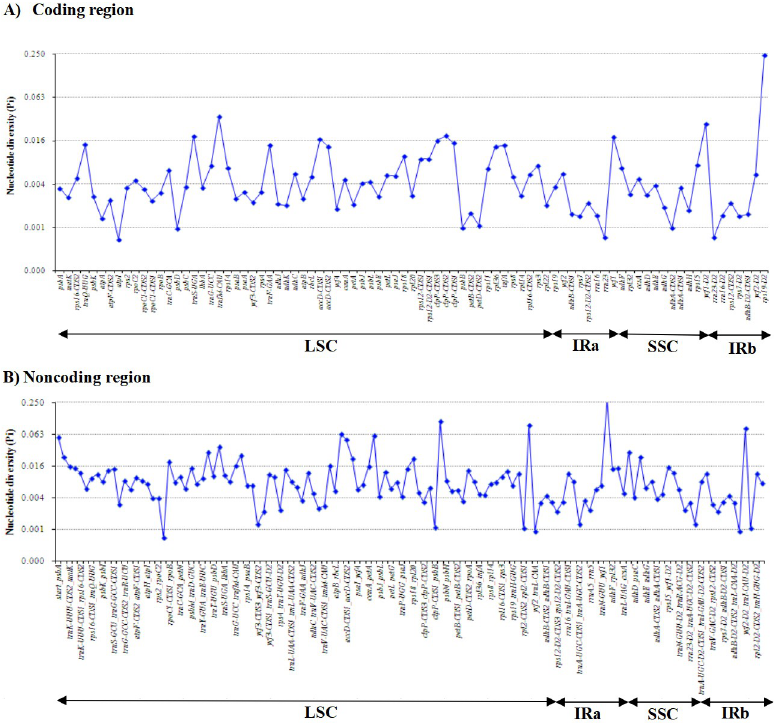
Fig 8. Sliding window analysis of the whole chloroplast genomes among four Zingiber species. Window length: 800 bp; step size: 200 bp. X-axis: position of the window midpoint.